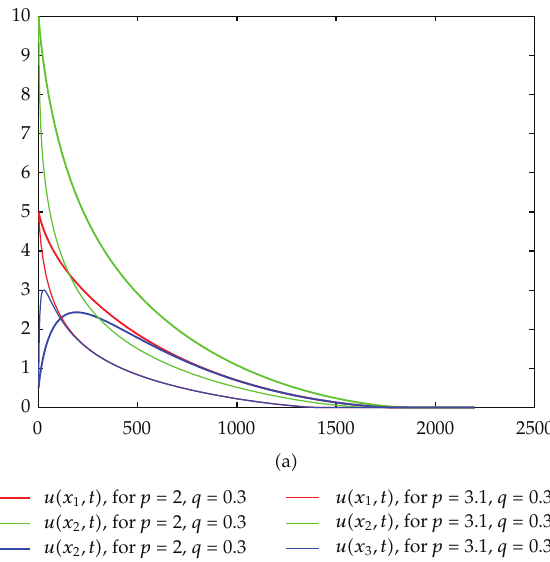
Figure 2: Extinction of the